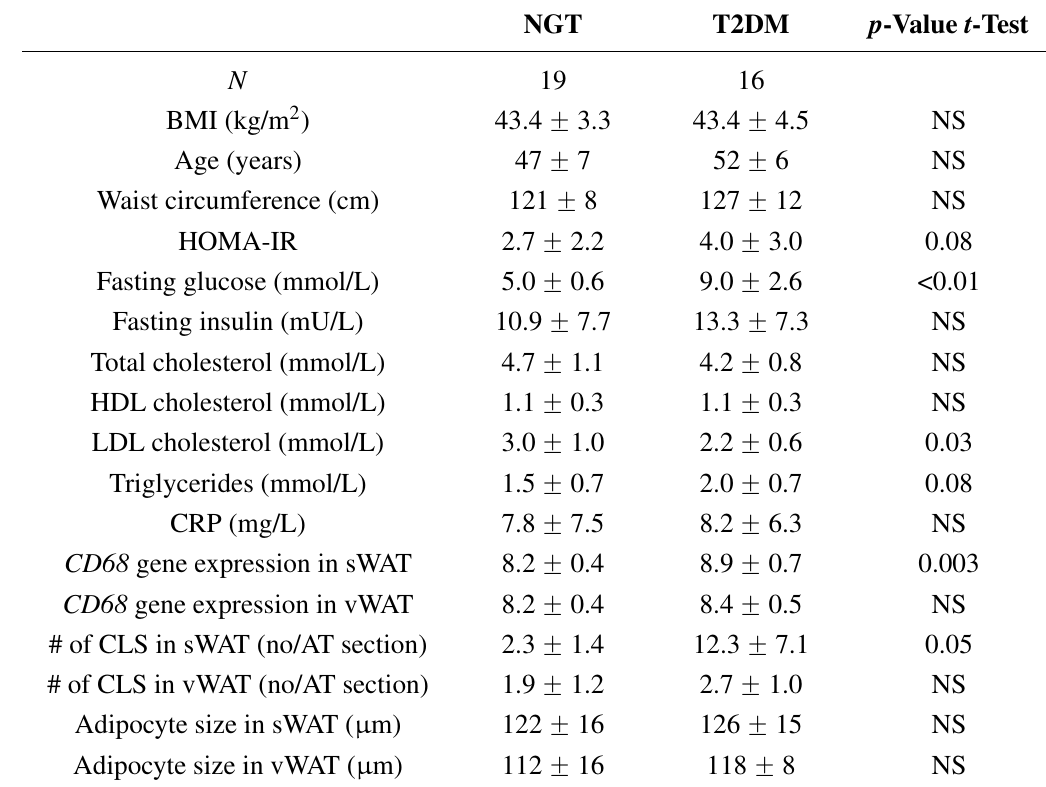
Table 1. Characteristics of the normal glucose tolerance (NGT) and type 2 diabetes mellitus (T2DM) women. Crown-like structures (CLS) were determined by